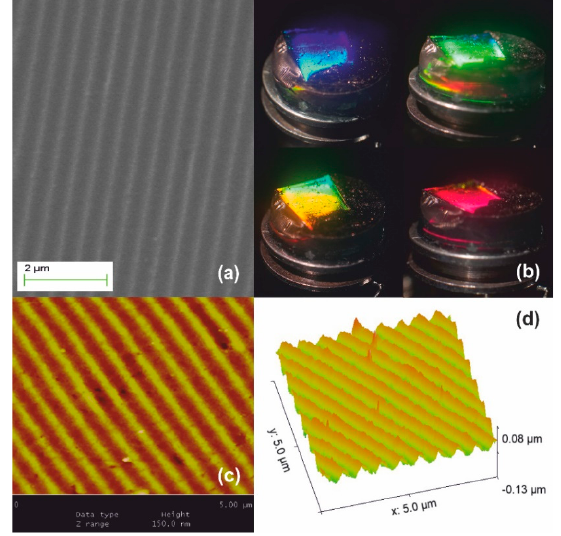
Figure 4. Xerogel Stage I systolic processing via natural drying: ( a ) SEM micrograph of grating with Λ xero-I ~450 nm, results by SF ~2.2× contraction of the original molded gel. ( b ) The structural coloration by white light diffraction. The top-right image shows diffraction of green wavelength and undiffracted red/yellow light transmitted through the bulk. ( c ) AFM image and ( d ) AFM surface relief presentation.